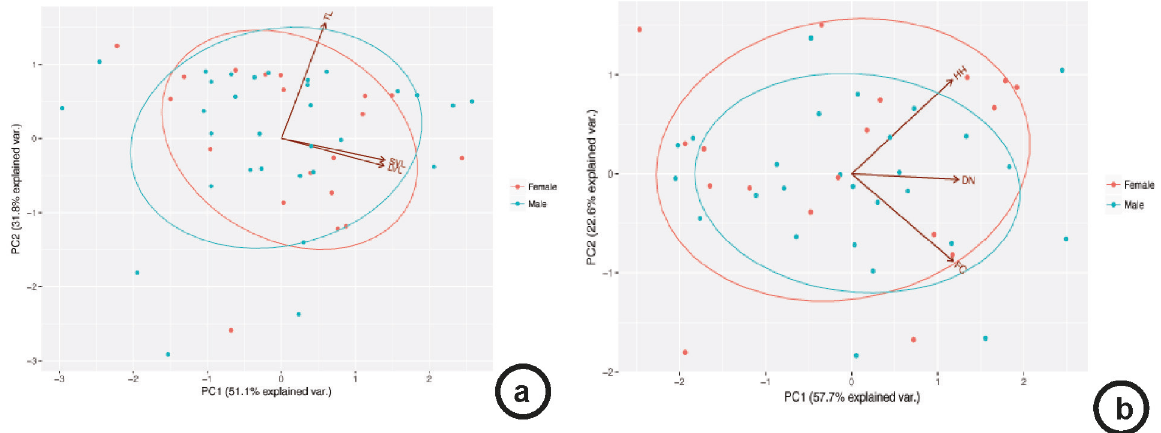
Figure 2. Graph of Principal Component Analysis (PCA) showing the variation of the snout-vent length (SVL), tail length (TL) and length of the vestigial hind limbs (LVL) (a, n = 50) and distance between the nostrils (DN), face commissure (FC), head height (HH) and head width (HW) (b, n = 45) (morphometric variables signaled by the brown arrow) in relation to sex (male in blue and female in pink) of Ophiodes striatus .